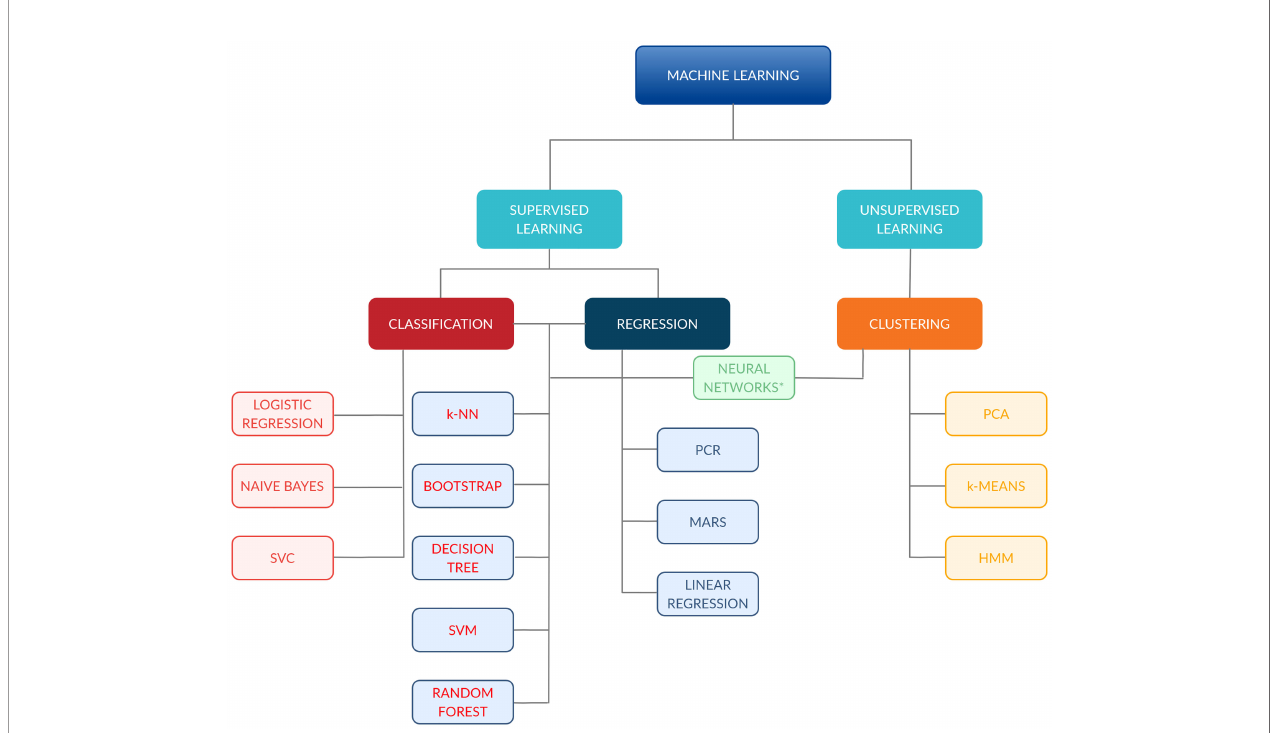
FIGURE 3 | Classi fi cation of the machine-learning algorithms included in the analysis. *Comprehend: ANN, CNN and FCNN. ANN, Arti fi cial Neural Network; CNN, Convolutional Neural Network; FCNN, Fully CNN; HMM, Hidden Markov Model; k-NN, k-Nearest Neighbour; MARS, Multiadaptive Regression Splines; PCA, principal component analysis; PCR, principal component regression; SVC, support vector classi fi er; SVM, support vector